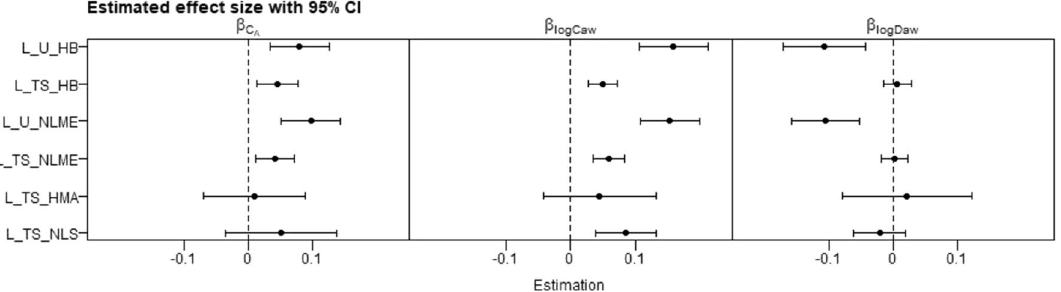
Figure 4. Estimated associations between NO parameters and standardized height in the CHS using 6